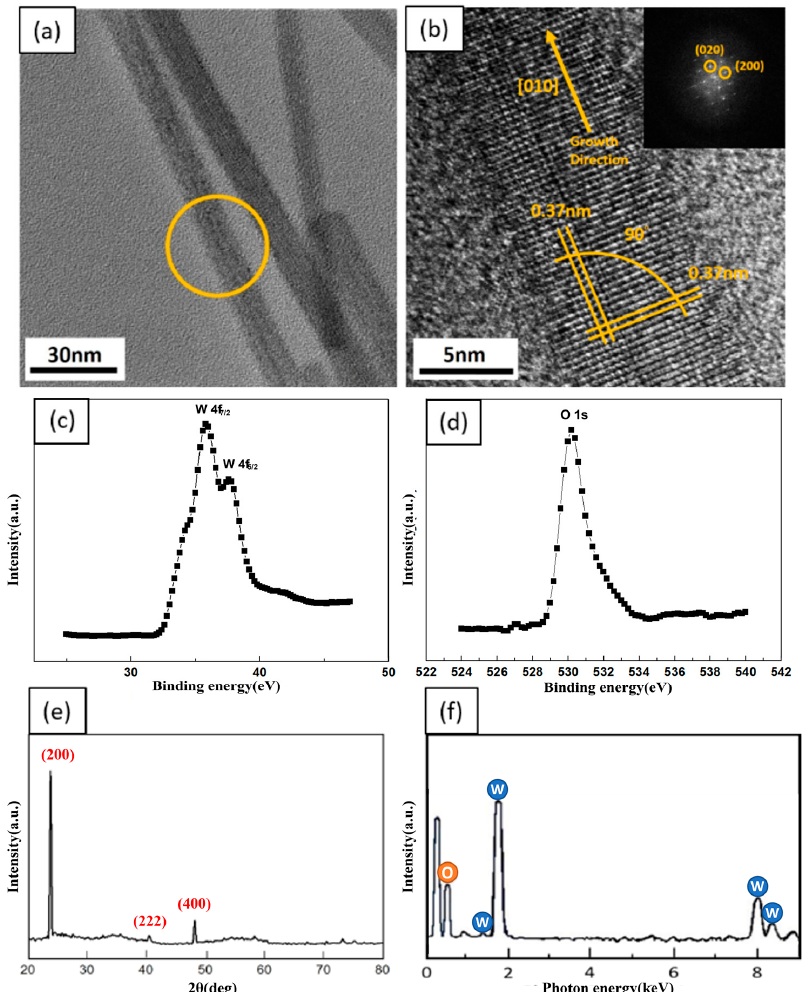
Figure 5. Characterization of WO 3 NWs grown at 700 °C. ( a ) Low resolution TEM image. ( b ) HR- TEM image and inset is FFT pattern. ( c ) XPS analysis of W4f and ( d ) O1s core levels. ( e ) XRD pattern. ( f ) EDS analysis.